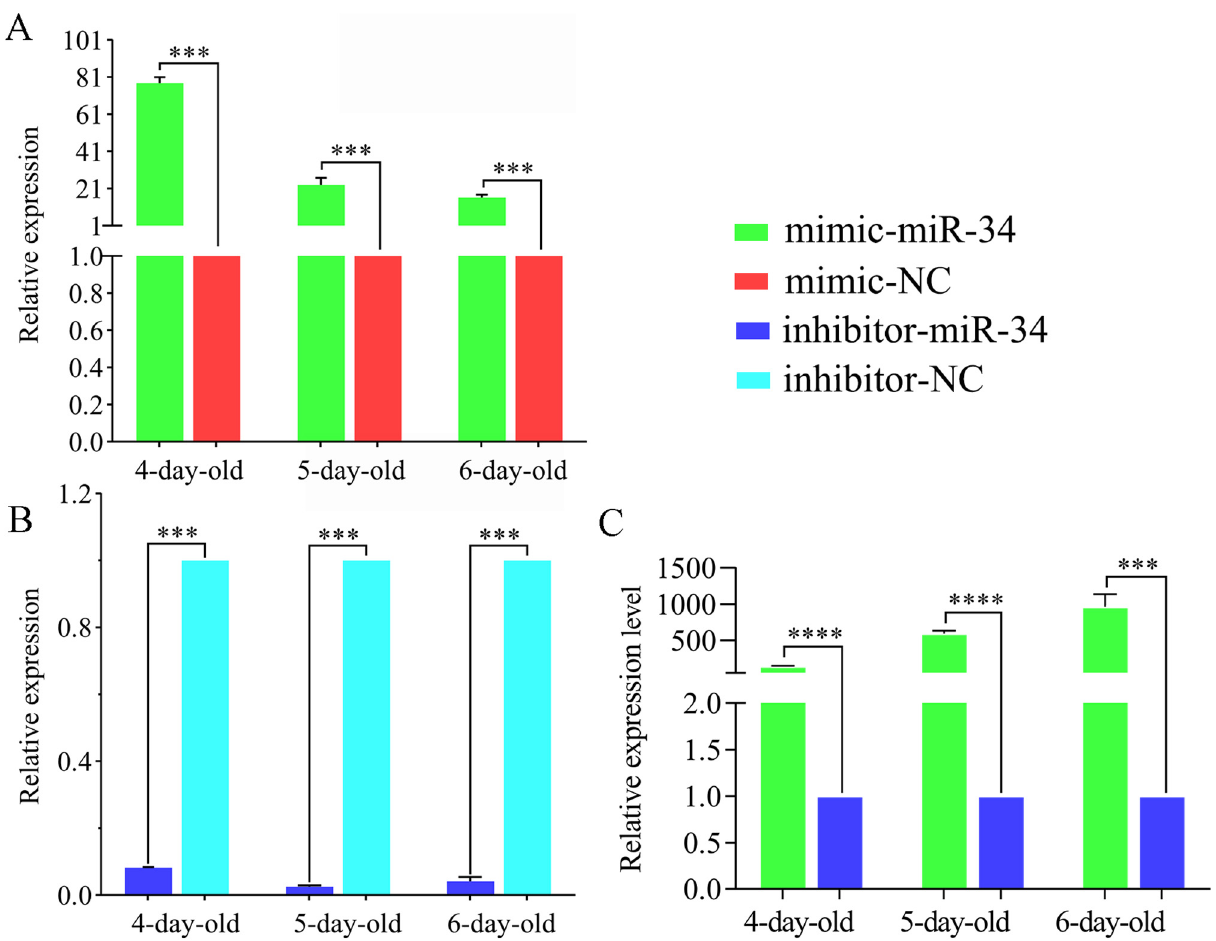
Figure 3. Determination of relative expression level of ame-miR-34 in un-infected A. mellifera larval guts. ( A ) Relative expression level of ame-miR-34 in the larval guts after feeding mimic-miR-34; ( B ) relative expression level of ame-miR-34 in the larval guts after feeding inhibitor-miR-34; ( C ) relative expression level of ame-miR-34 in the larval guts after feeding mimic-miR-34 in comparison with that after feeding inhibitor-miR-34. Data were presented as mean SD and subjected to Student’s t -test, ***: p < 0.001, ****: p < 0.0001.